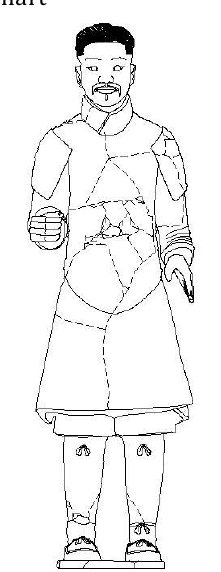
Figure 1 Cultural fragments digital flow